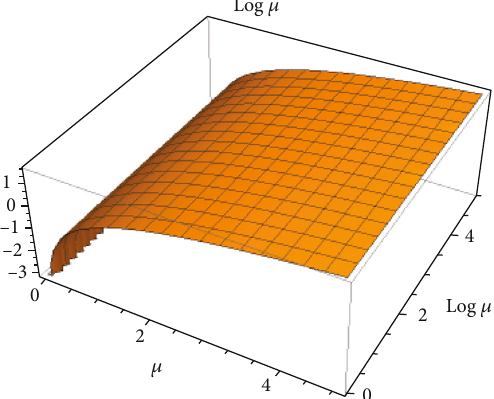
Figure 1: The graphical surface represents a 3-D view of F -contractive function F ð u Þ = log u where u ∈ ð 0, 5 Þ , v ∈ ð 0, 5 Þ and w ∈ ℝ +